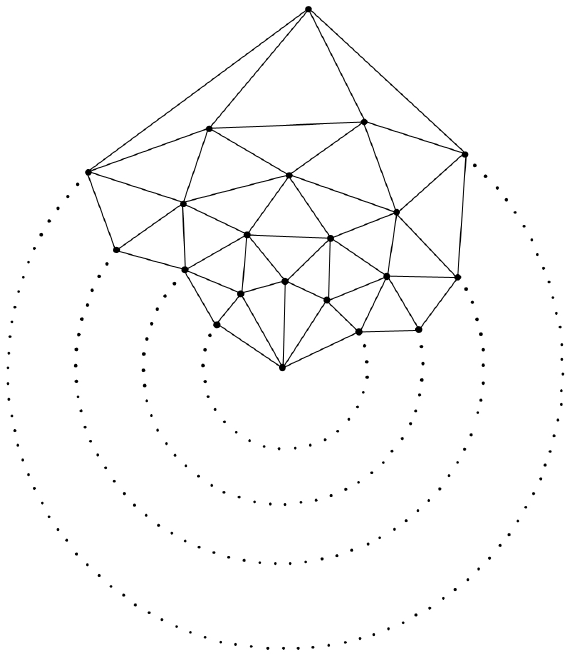
Figure 3. The graph of convex polytope B n .